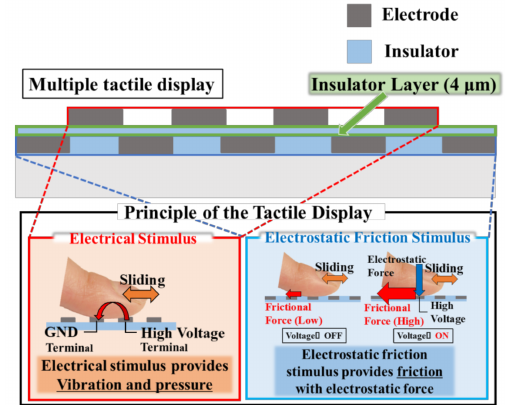
Figure 2. The principle of the proposed multiple tactile